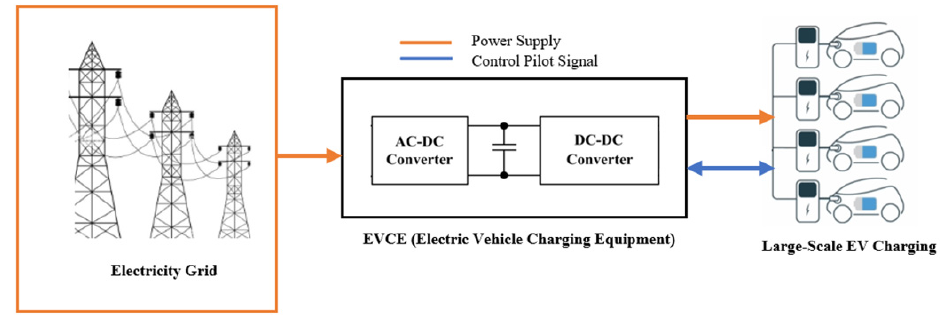
Figure 1. Integration of Large-Scale EV Charging on the Grid.